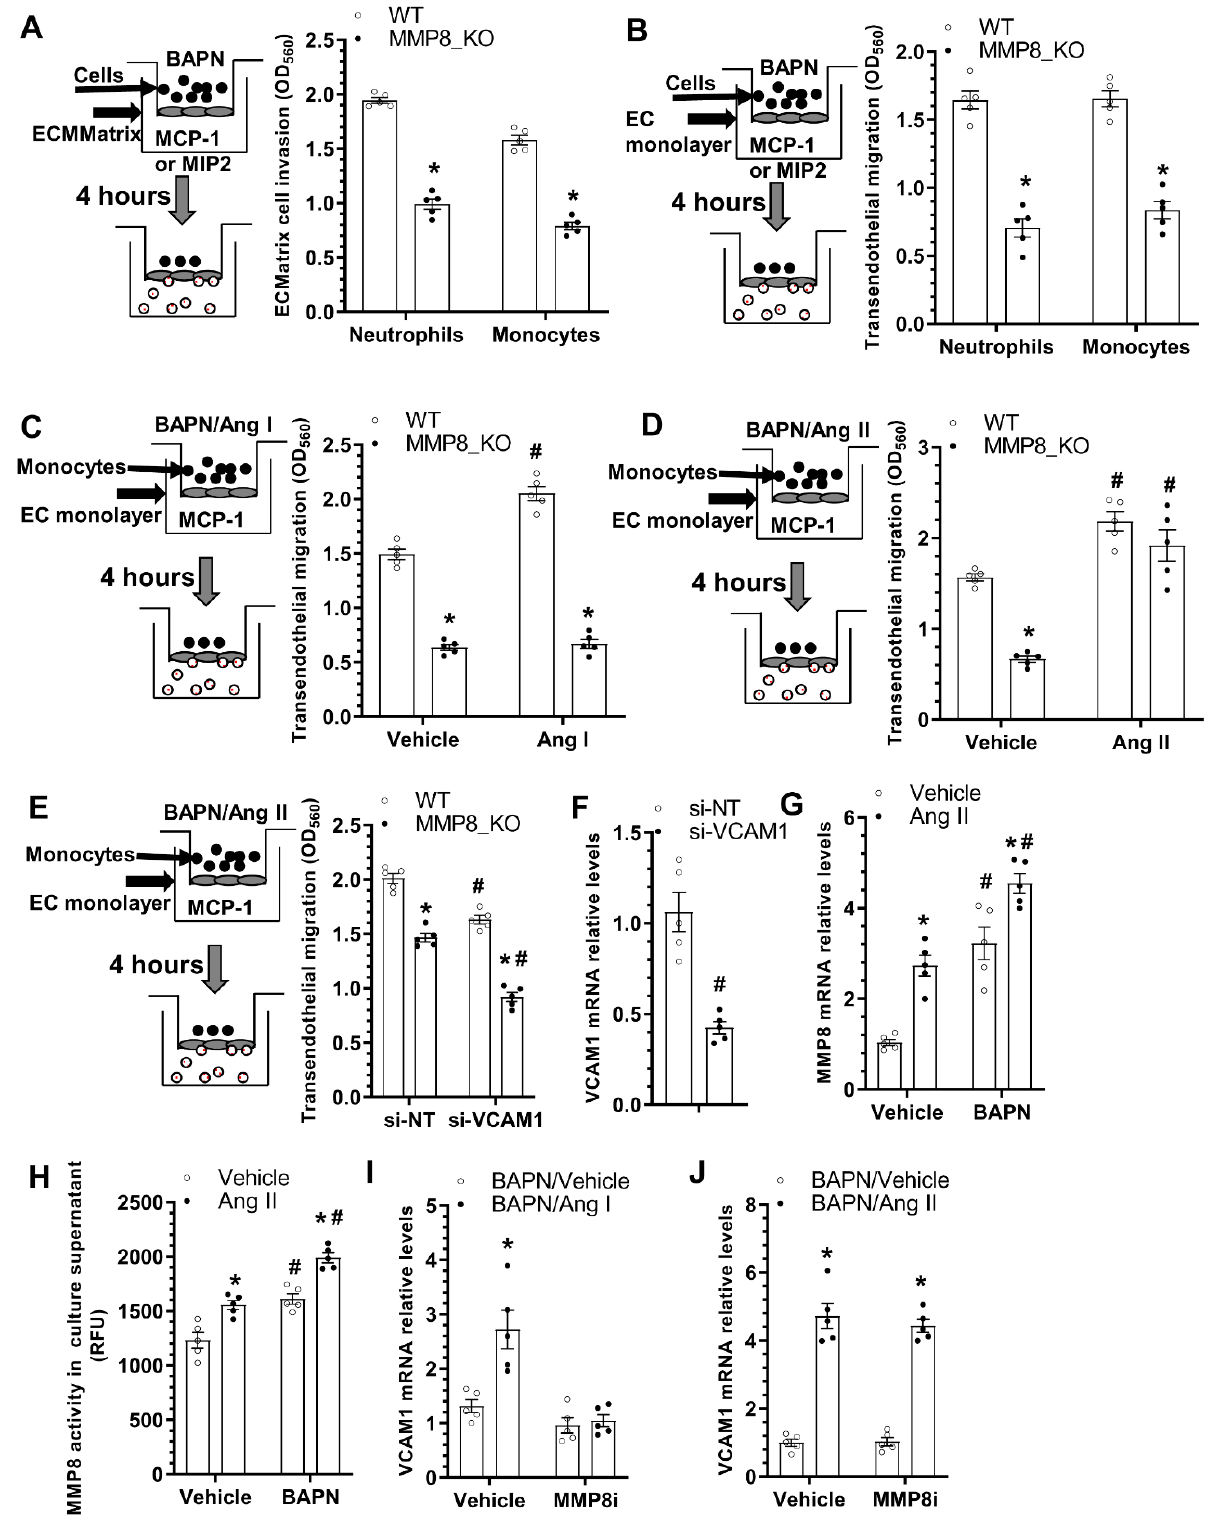
Figure 5. MMP8-deficiency causes decreased inflammatory cell invasion & transendothelial migration. Bone marrow neutrophils or monocytes were isolated from WT or MMP8_KO mice, and subjected to cell invasion ( A ) and transendothelial migration ( B – E ) assays, respectively. ( A ) The invasion capacity of cell was detected using QCM ECMatrix Cell Invasion Assay. ( B ) Cell transendothelial migration analysis. Mouse endothelial cells (EC, C166 cells) were pre-cultured onto transwell inserts (pore size: 8 µm) to form an EC monolayer, followed by transendothelial assays in response to 100